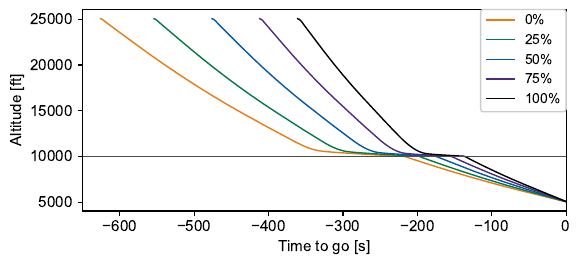
Figure 6. Descent profiles of a B777 aircraft as a function of time with different speed brake angles δ i (indicated by color). At 25,000 ft, the B777 flies with Mach 0.75; below 10,000 ft 240 kt are mandatory. A maximum deceleration path angle of 0.5 ◦ and 9 t payload are considered.